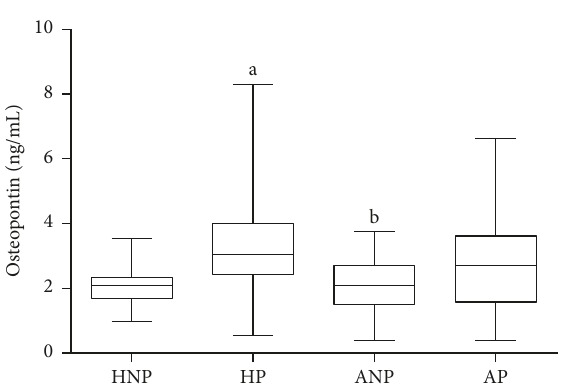
Figure 1: Circulating osteopontin levels in healthy nonpregnant and pregnant and in asthmatic nonpregnant and pregnant subjects (data are expressed as median [interquartile range]). HNP: healthy non- pregnant; HP: healthy pregnant; ANP: asthmatic nonpregnant; AP: asthmatic pregnant. a 𝑝 < 0.05 versus HNP; b 𝑝 < 0.05 versus HP.